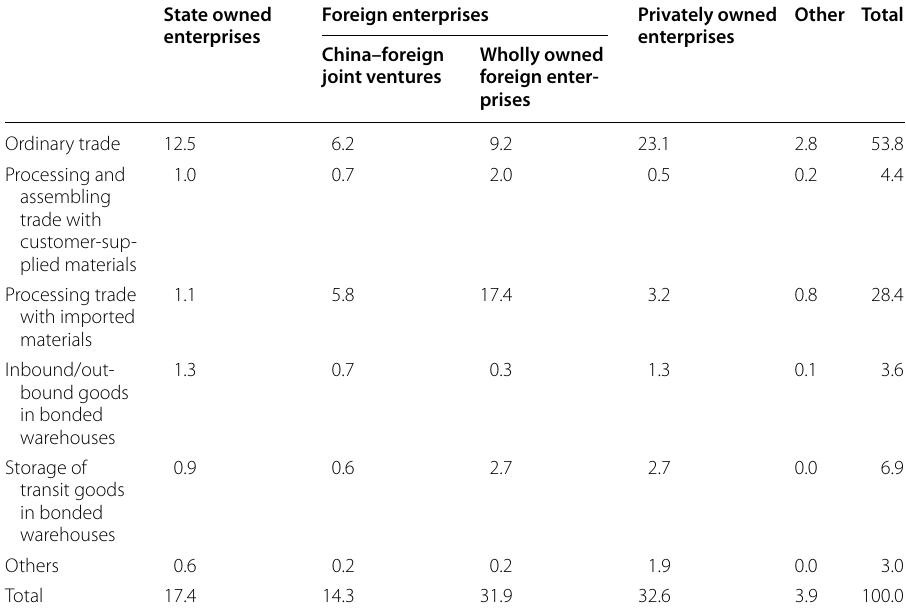
Table 1 Composition of China’s trade by trade mode and type of enterprise (2014). Source : China